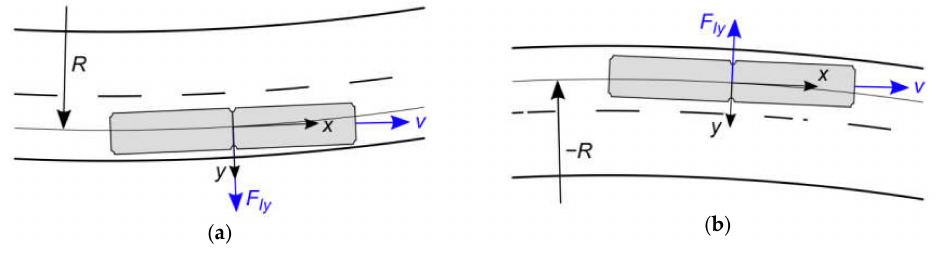
Figure 4. Centrifugal forces with: ( a ) positive radius; ( b ) negative